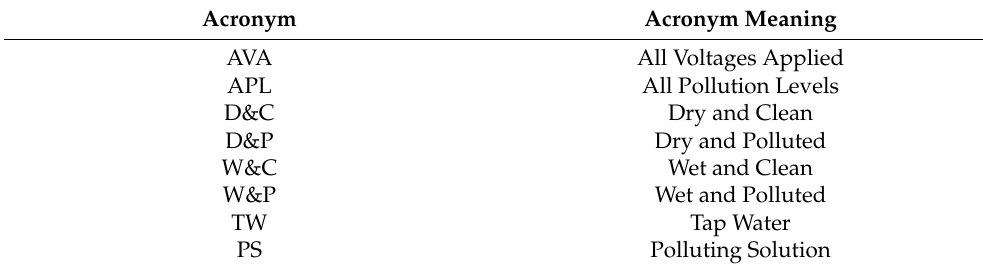
Figure 2. Flowchart of the measuring procedure. Table 2. List of abbreviations in the flowchart in Figure 2.